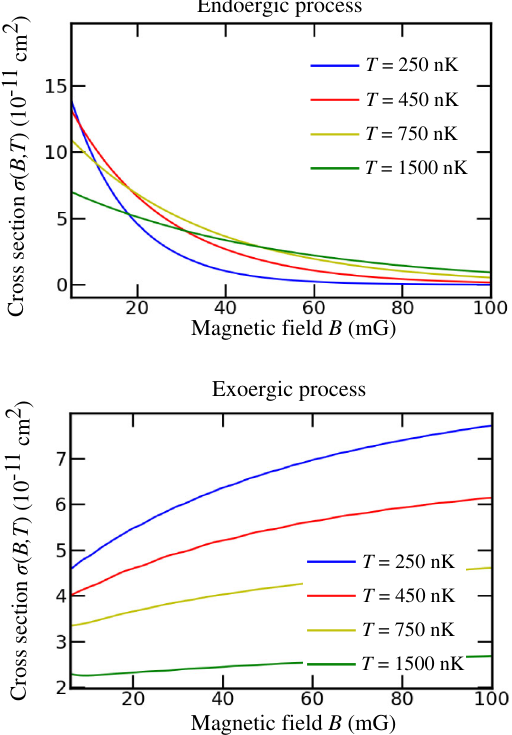
FIG. 7. Scattering cross sections for endoergic SE (top) and exoergic SE (bottom) for Cs in the state m ¼ 0 . The cross sections shown here include the effect of m F; Rb finite temperature and are plotted for four different temperatures T (250, 450, 750, and 1500 nK).